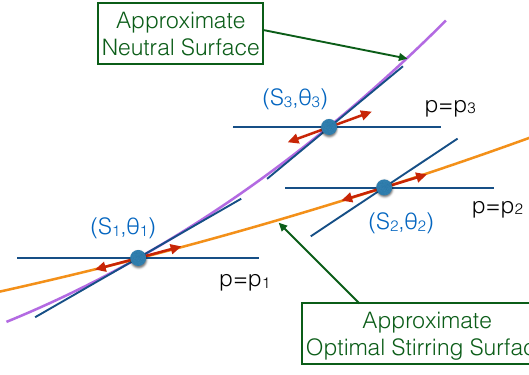
Figure B2. Schematics illustrating approximate neutral surfaces and approximate optimal stirring surface obtained by making a continuous surface to be tangent at all points to the neutral tangent plane and to the optimal stirring